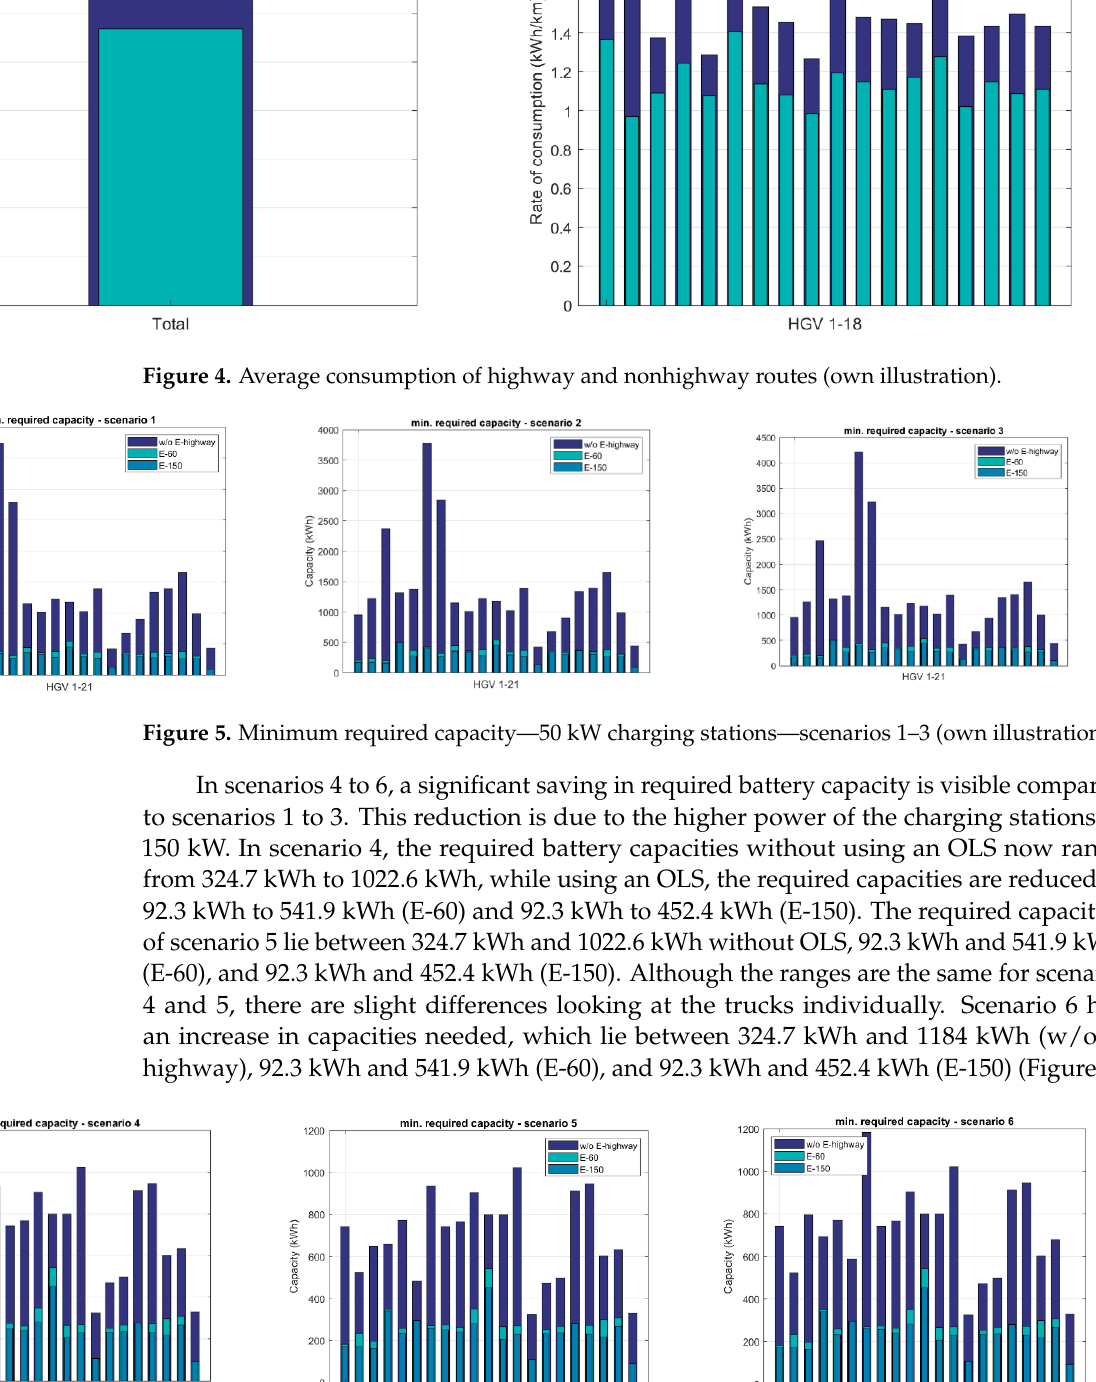
Figure 6. Required minimum capacity—150 kW charging stations—scenarios 4–6 (own illustra- tion).